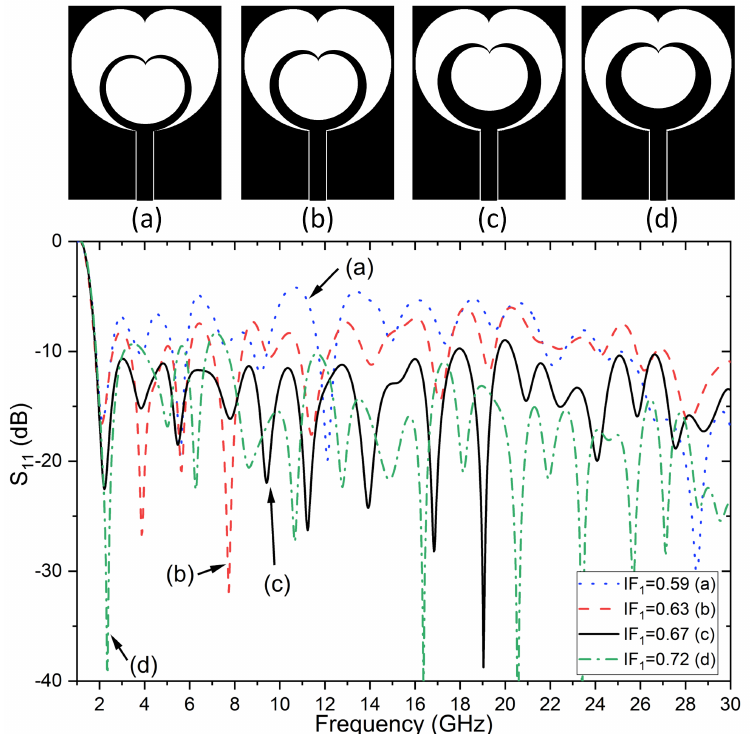
Figure 3. The simulated reflection coefficients of the first order fractal antenna for different iteration factors IF 1 = a 3 / a 2 obtained by changing the value of parameter a 2 : ( a ) a 2 = 3.91, ( b ) a 2 = 4.18, ( c ) a 2 = 4.45 and ( d ) a 2 = 4.72. The parameters are a 1 = 6.6 and a 3 =